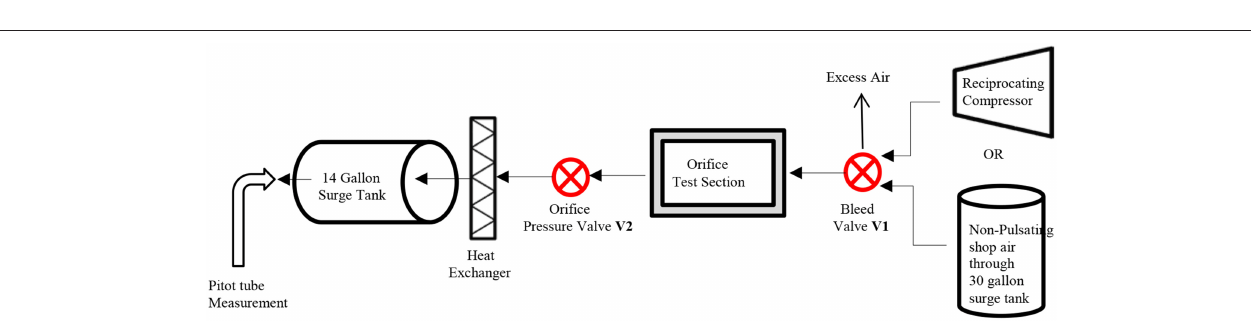
FIGURE 2 | A sketch of the pulsating flow